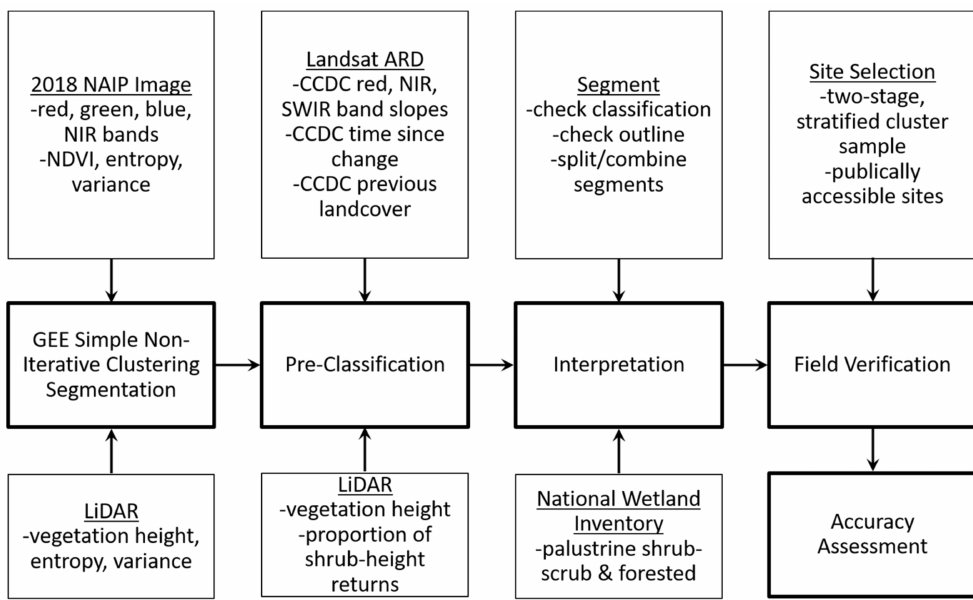
Figure 1. Workflow for a multi-source, object-based approach to classification of young forest and shrubland vegetation using image segmentation, pre-classification, interpretation, field verification, and accuracy assessment. NAIP: National Agriculture Imagery Program. ARD: Analysis Ready Data. NDVI: Normalized Difference Vegetation Index. GEE: Google Earth Engine. CCDC: Continuous Change Detection and Classification. NIR: Near Infrared. SWIR: Shortwave